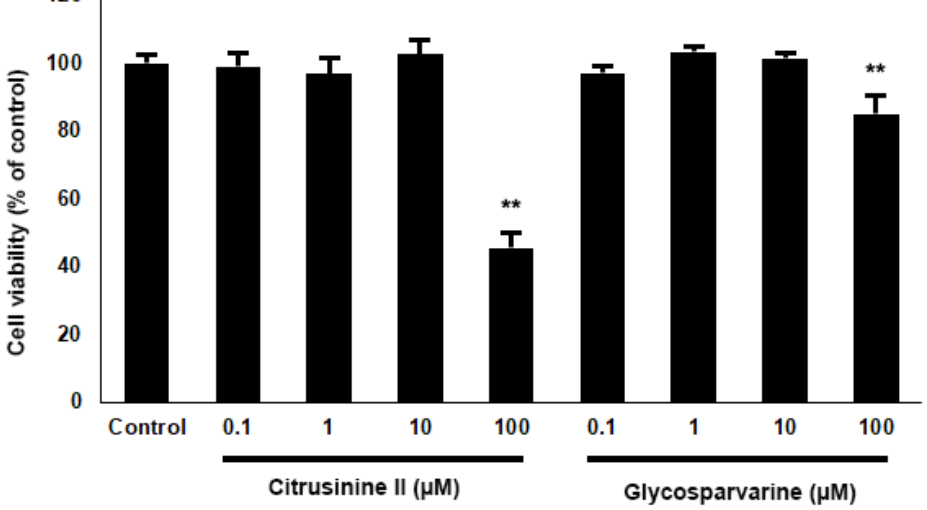
Figure 7. Effects of citrusinine II and glycosparvarine on cell viability of SH-SY5Y cells. The values are reported as mean ± SD ( n = 4), One-way ANOVA followed by the Tukey test was used to compare between control and test inhibitors, ** p <